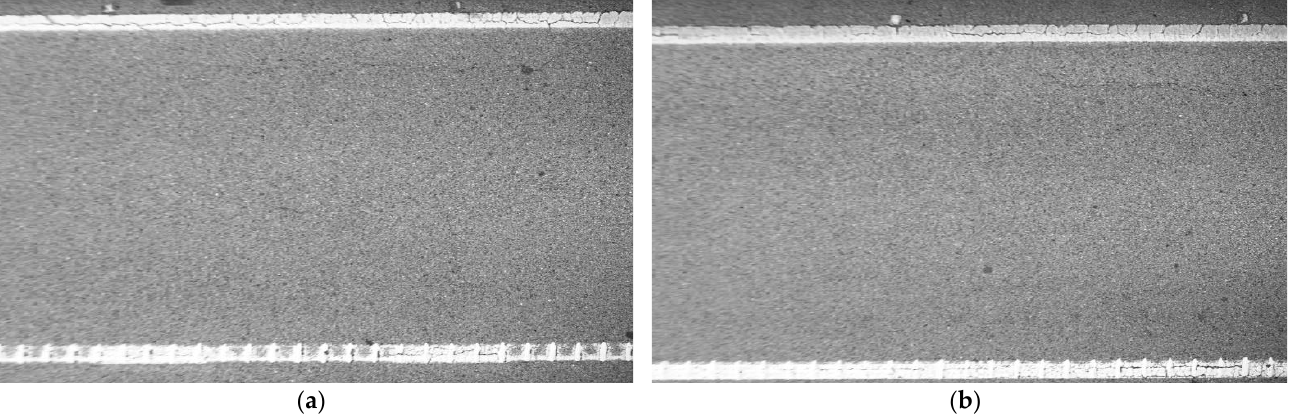
Figure 18. Images relating to the section [76,300; 76,400]: ( a ) longitudinal crack in the pavement and within the upper white lane marking (the system classi fi ed the image as non-crack); ( b ) longitudinal crack in the pavement (the system classi fi ed the image as non-crack).